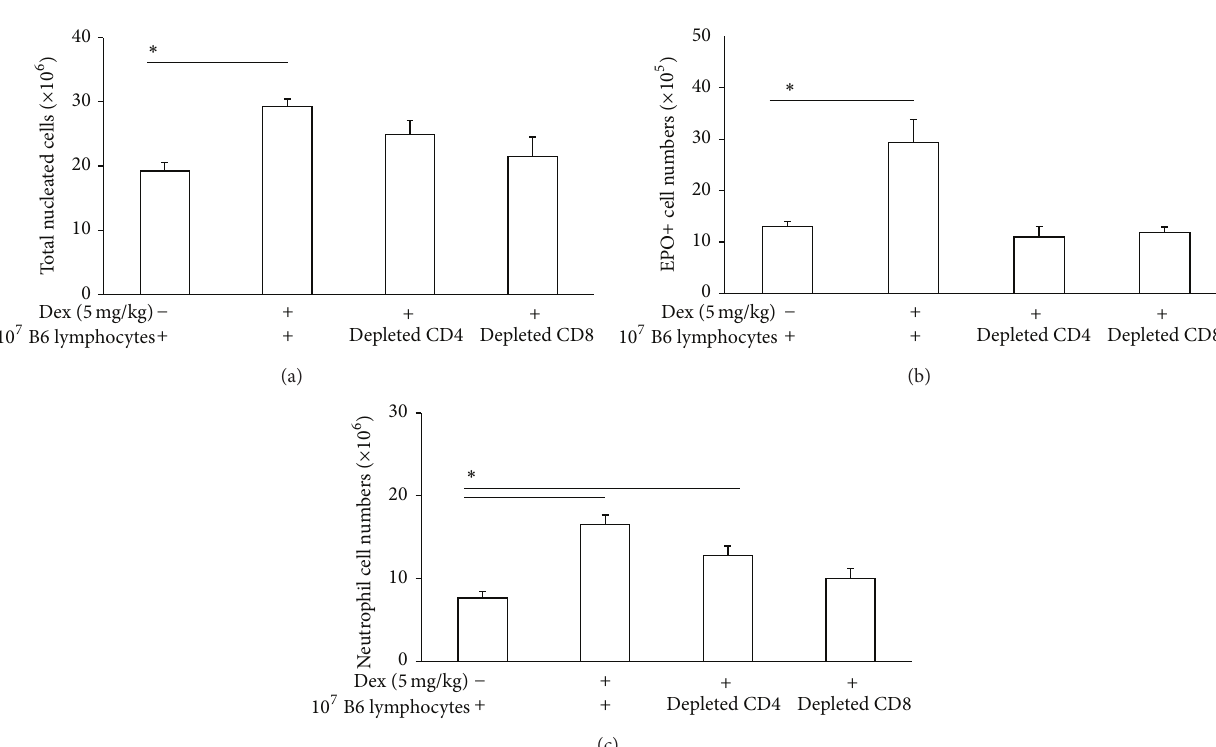
Figure 5: Short-term reconstitution of responses to dexamethasone in Pfp mice by transfer of B6 splenic lymphocytes. Data are Mean + SEM of the total nucleated cells (a), EPO+ cells (b), and neutrophils (c) in freshly harvested bone-marrow of Pfp mice which had received total nylon-wool purified wild-type lymphocytes, or CD4-depleted lymphocytes, or CD8-depleted lymphocytes, i.v., 48 h before dexamethasone (5mg/kg) i.p. injection. For controls given total lymphocytes before saline i.p. (first column, from left to right) and for experimental groups given total lymphocytes (second column), CD4-depleted lymphocytes (third column), or CD8-depleted lymphocytes (fourth column) before dexamethasone, groups had, respectively, 𝑛 = 4 , 𝑛 = 10 , 𝑛 = 7 , and 𝑛 = 4 . ∗ Significant differences between the indicated groups.